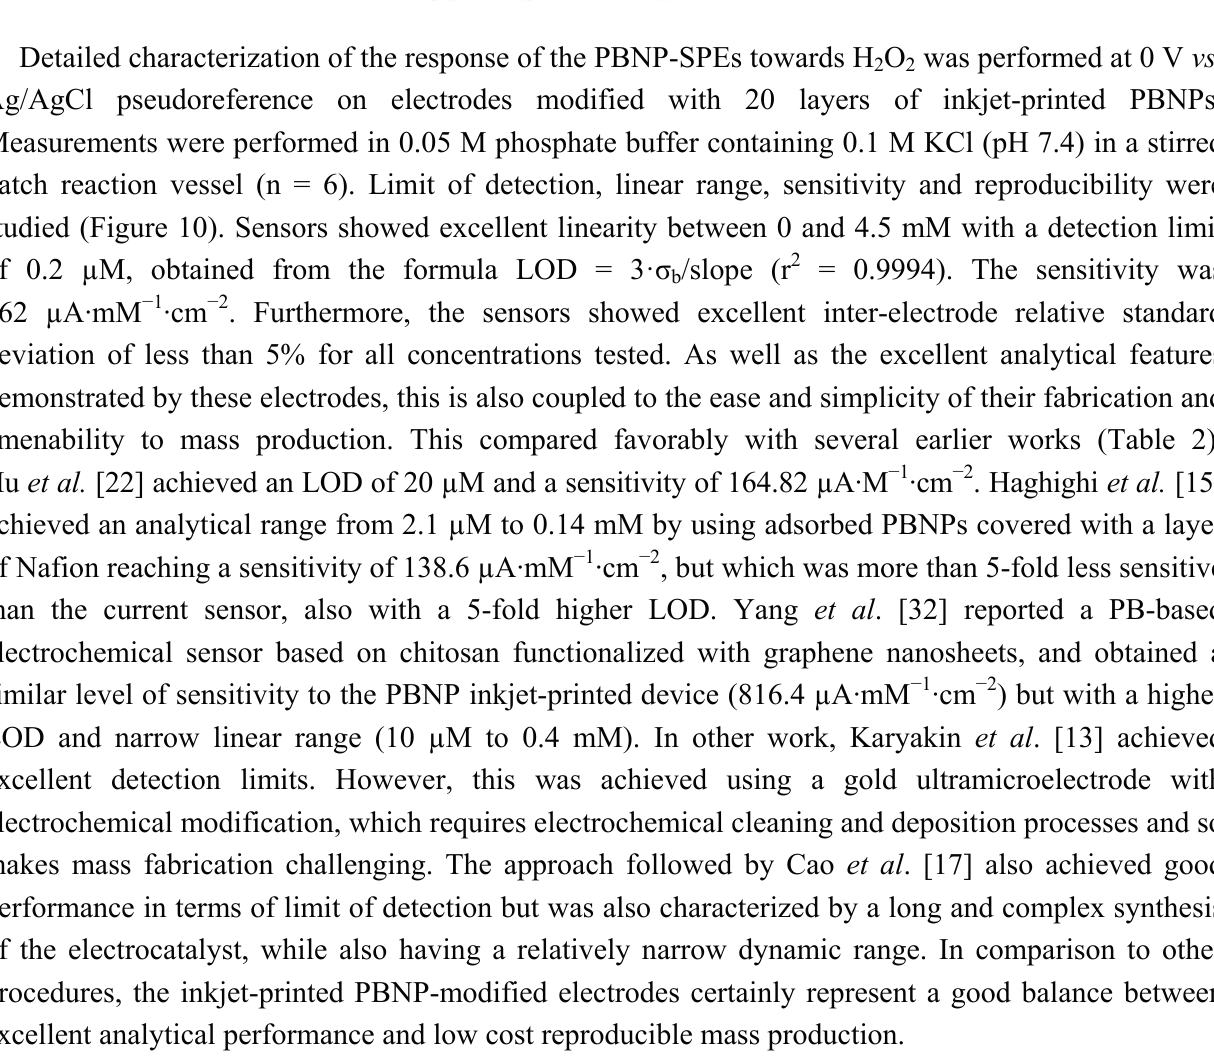
Figure 9. Selection of the optimum applied potential for the amperometric measurement of H